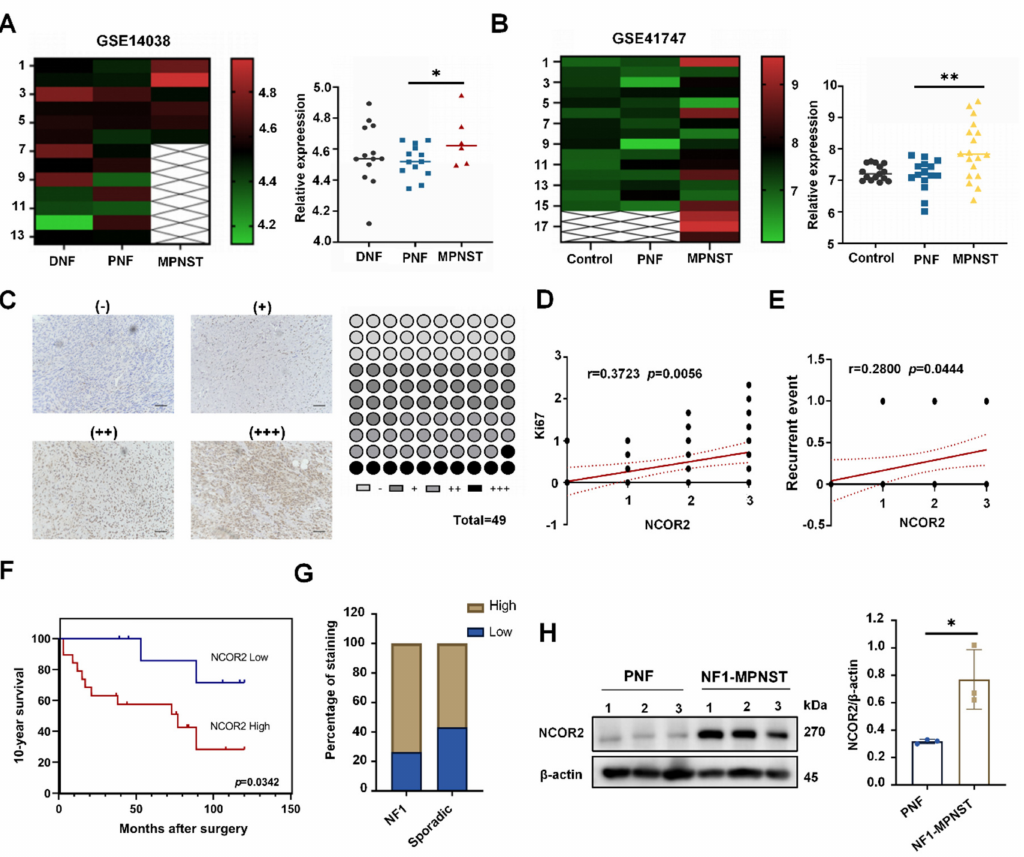
Figure 1. NCOR2 expression is significantly elevated in NF1-derived MPNSTs and is associated with patient 10-year survival time. ( A ) NCOR2 expression was significantly higher in MPNSTs than in PNFs in GSE14038; * p < 0.05. ( B ) NCOR2 level was higher in mouse MPNSTs than PNFs in GSE41747; ** p < 0.005. ( C ) Representative IHC images of NCOR2 expression in tissue microarray. Scale bar, 50 µ m. 63% MPNST tissues showed medium or high NCOR2 expression. ( D ) The expression of NCOR2 was positively correlated with Ki67; r = 0.3723; p = 0.0056. ( E ) There is a weakly positive correlation between NCOR2 expression and local recurrence; r = 0.2800; p = 0.0444. ( F ) Kaplan– Meier survival analysis showing that the 10-year survival of the NCOR2-high expression group was significantly shorter than that of low expression group, p = 0.0342. ( G ) NCOR2 high expression accounted for a larger proportion of NF1-derived MPNSTs (73.7%, 14/19). ( H ) WB showing that NCOR2 protein levels were significantly increased in NF1-derived MPNST fresh samples compared with that in PNFs; β -actin was used as the control. Data are shown as mean ± S.D., n = 3; * p < 0.05 (seen in Supplementary File